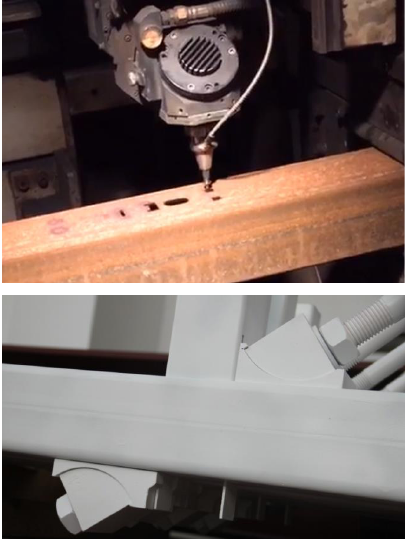
Figure 1: Laser cutting of chord lock (the top). Elements of II genera- tion N type RHS truss joint (bottom)